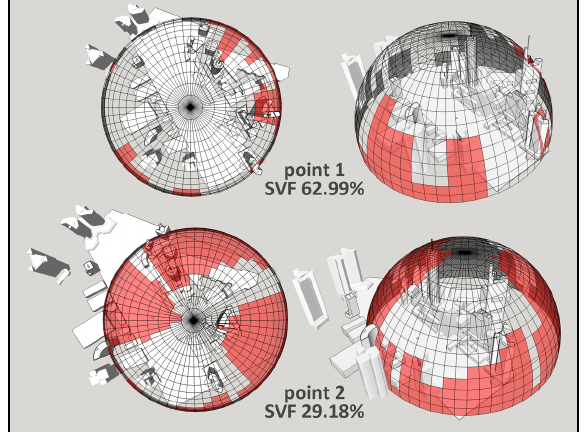
Figure 14. Impact of tall buildings on perception of public spaces by Sky View Factor (SVF) for two different locations in centre of Frankfurt (cityGML – LOD2), by: author While moving and simulating position of user just outside